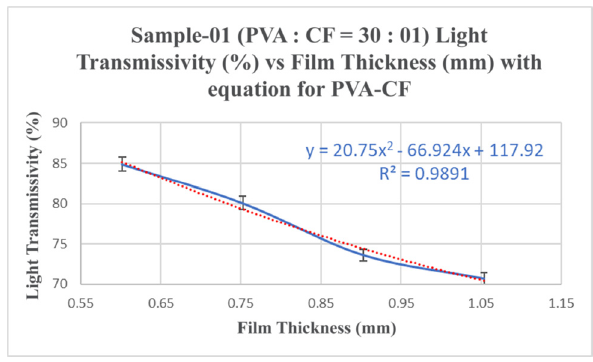
Figure 16: Sample - 01 ( CF:PVA = 0.1:30 ) light transmittance ( % ) versus fi lm thickness ( mm ) with equation for PVA - CF. The dotted lines represent the polynomial fi tted curve and the linear fi tted.